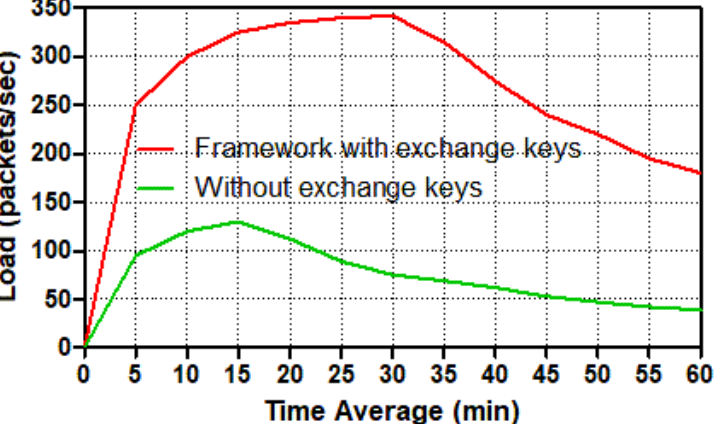
Figure 10. Load (packets/s) in the control center for different tasks.